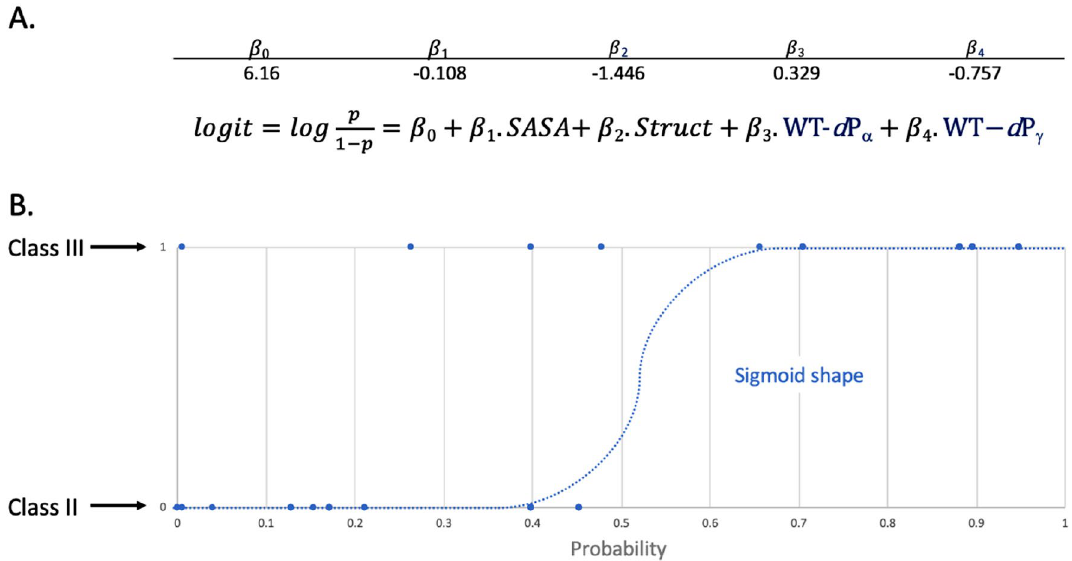
Figure 6. Logistic regression model results. ( A ) Coefficients obtained for the best predictive model and the logistic regression equation of the model; ( B ) Of note, several points superimpose themselves which gives the impression of having fewer points.